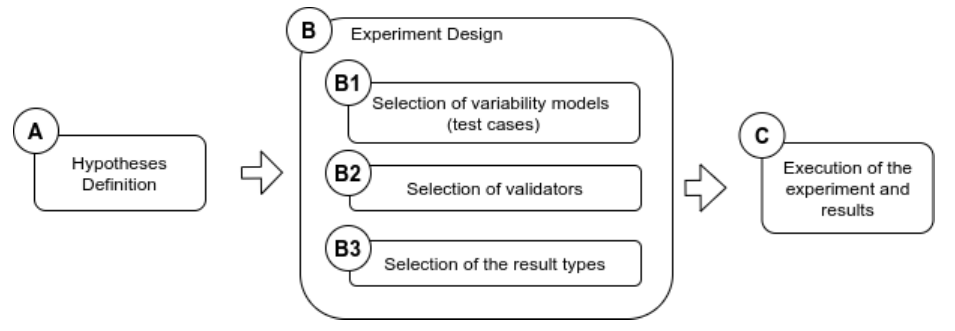
Figure 15. Process for designing the validation